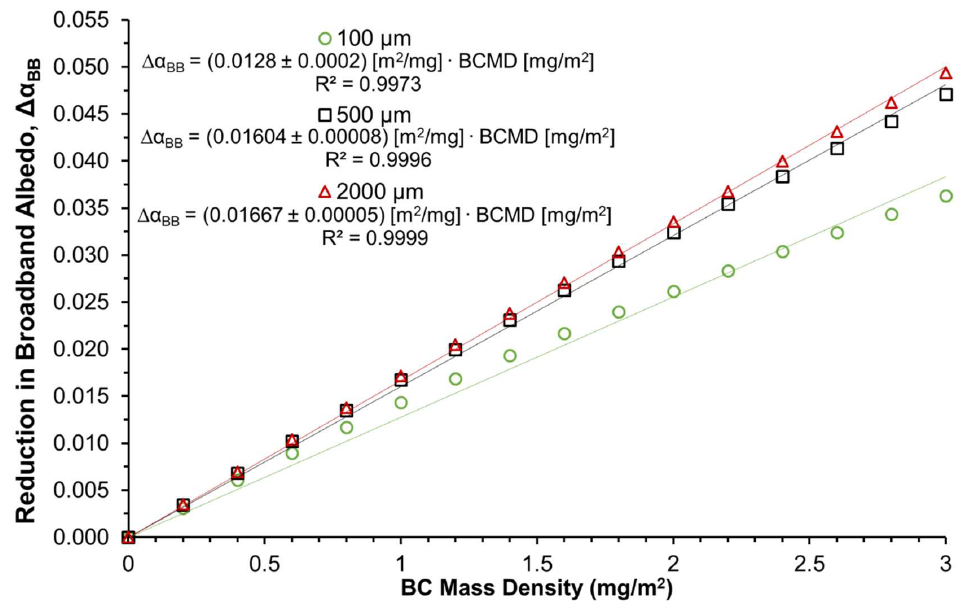
Figure 5. Reduction of snow surface albedo ∆ α BB as function of BCMD for three grain radii (i.e., 100, 500, and 2000 µ m) and the resulting slopes m for BCMD ≤ 3 mg / m 2 from a linear regression, where the error of m is the standard error value of the regression slope.